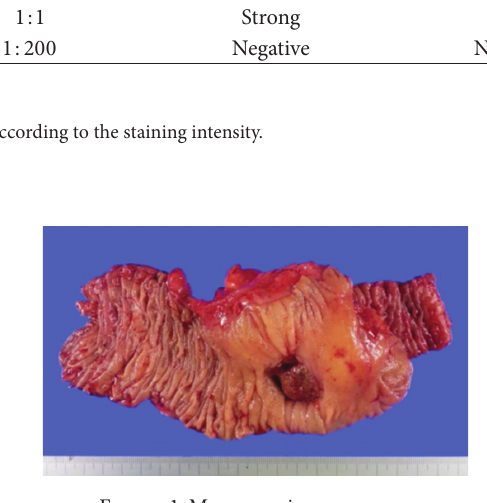
Figure 1: Macroscopic